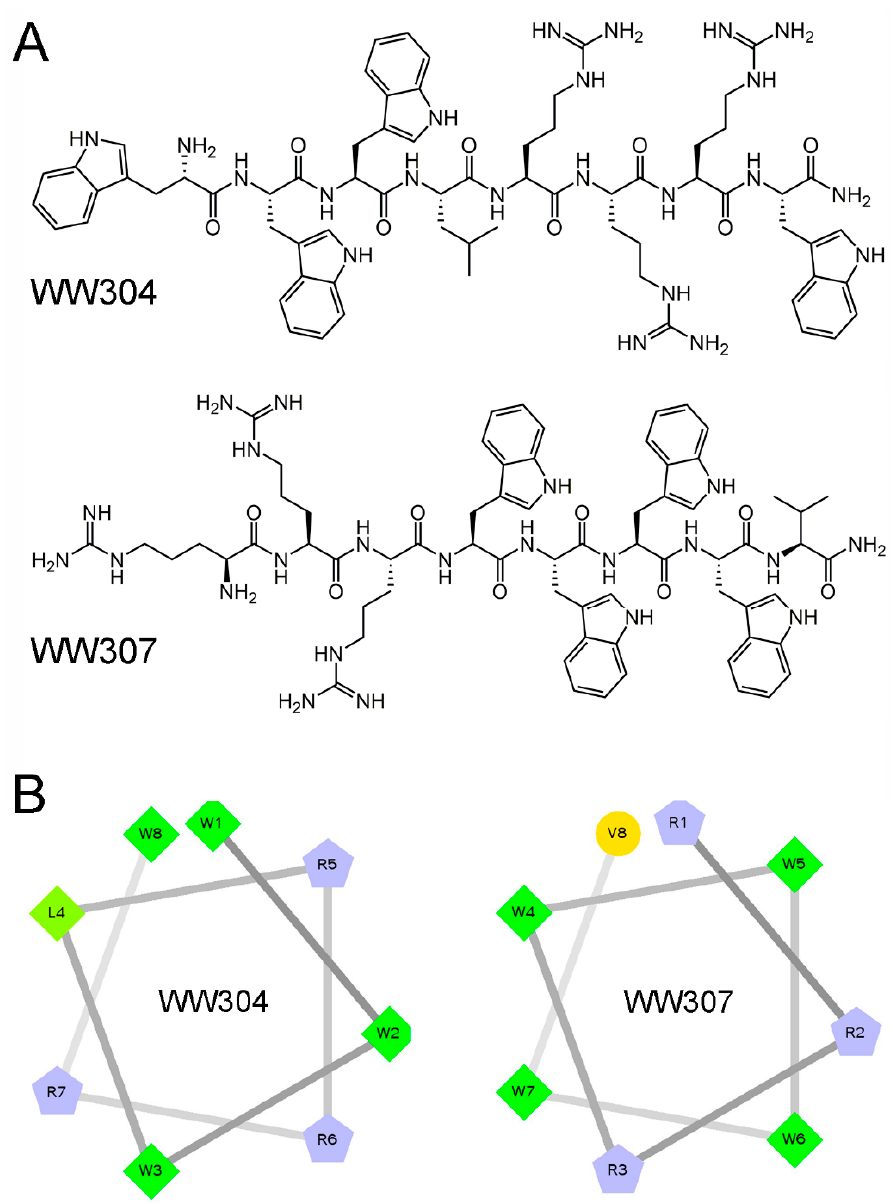
Figure 1. Design and characterization of two amphipathic Antimicrobial peptides (AMPs). ( A ) Chemical structures of two active AMPs (WW304 and WW307). ( B ) Helical wheel projections of WW304 and WW307. The hydrophilic residues as circles, hydrophobic residues as diamonds, and potentially positively charged as pentagons. Hydrophobicity is color coded as well: the most hydrophobic residue is green, and the amount of green is decreasing proportionally to the hydrophobicity, with zero hydrophobicity coded as yellow. Table 1. Key physicochemical parameters of amphipathic peptides.